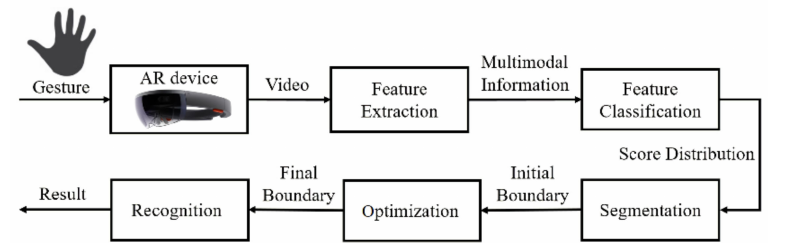
Figure 1. The framework of AR assisted assembly training (ARAAT) operation recognition. HoloLens takes trainee’s gesture videos of corresponding ARAAT task operations and the multimodal features are extracted from the gesture videos. After classification, the features are used for gesture segmenta- tion and optimization. By the recognition with the optimal gesture boundaries, the gesture results will be given to evaluate the standard and achievement of hand operations in ARAAT tasks.